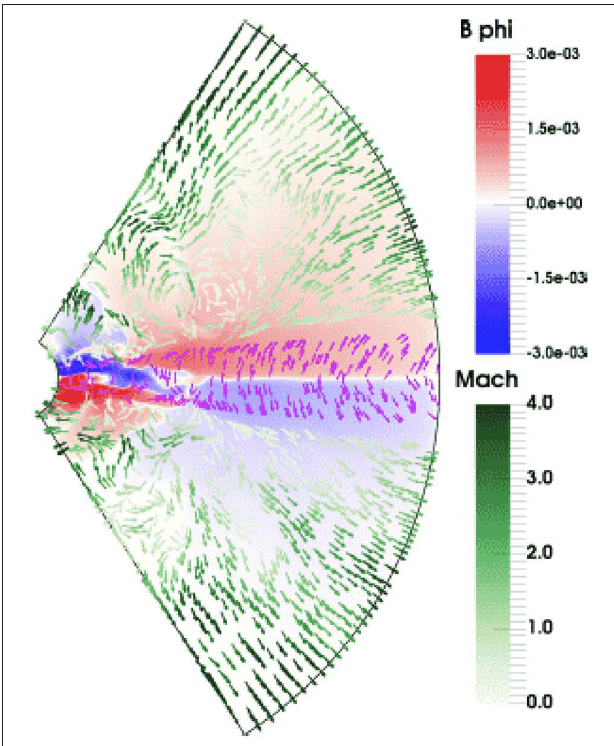
FIGURE 10 | A 2D, global non-ideal simulation of a disk and outflow showing: the toroidal magnetic field in color background (blue to red), the poloidal velocity field in units of local sound speed (Mach number)—green arrows in the corona, and the orientation of the angular momentum flux caused by magnetic stress (purple arrows in the disk). From Béthune et al. (2017) reproduced with permission c (cid:13)